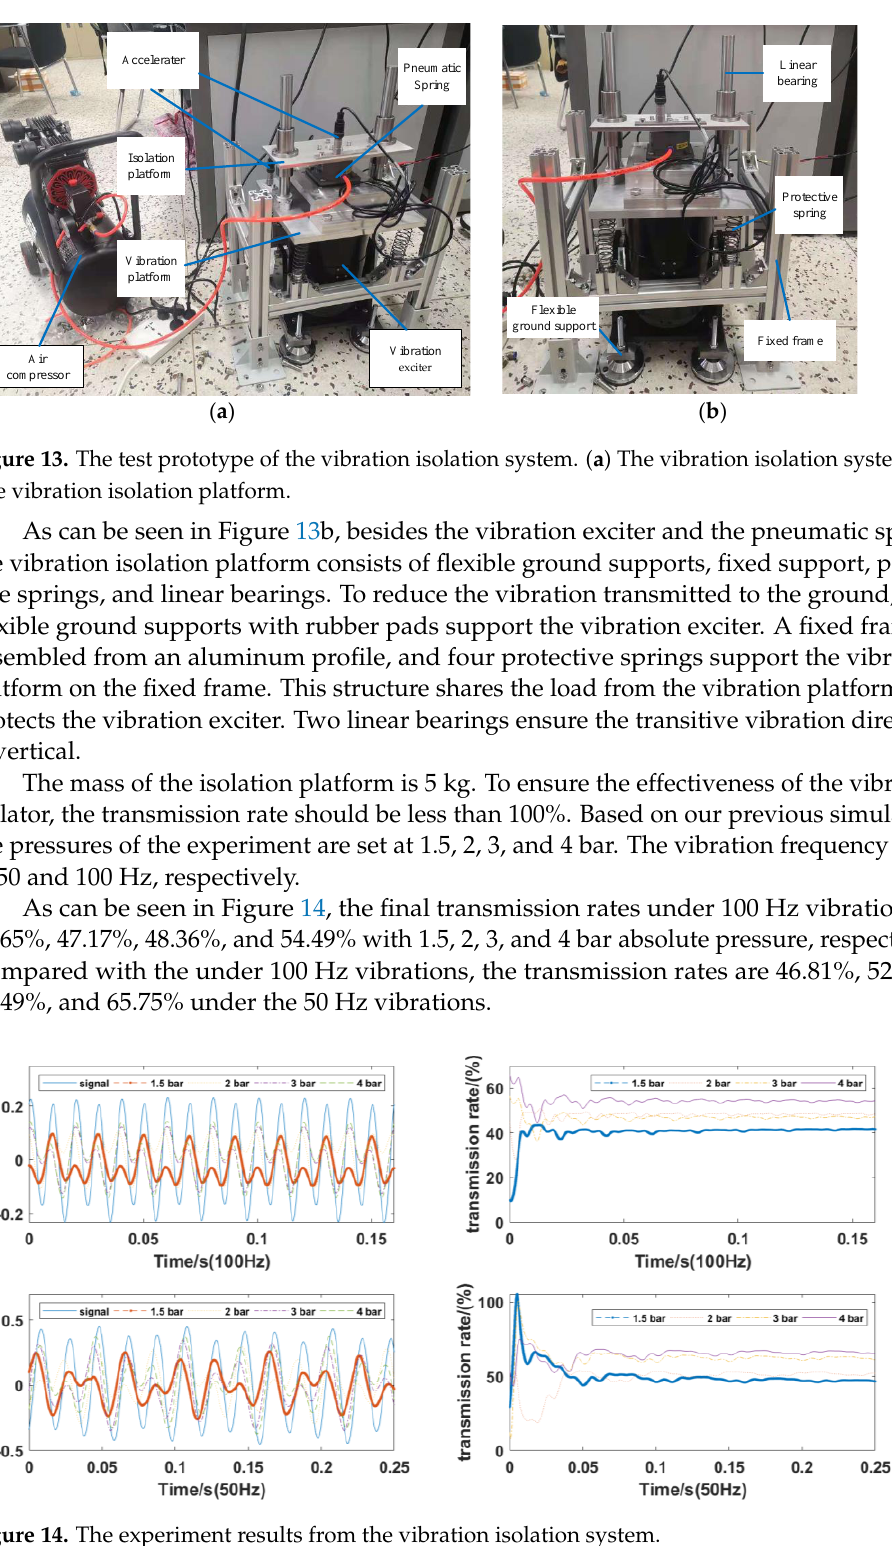
Figure 14. The experiment results from the vibration isolation